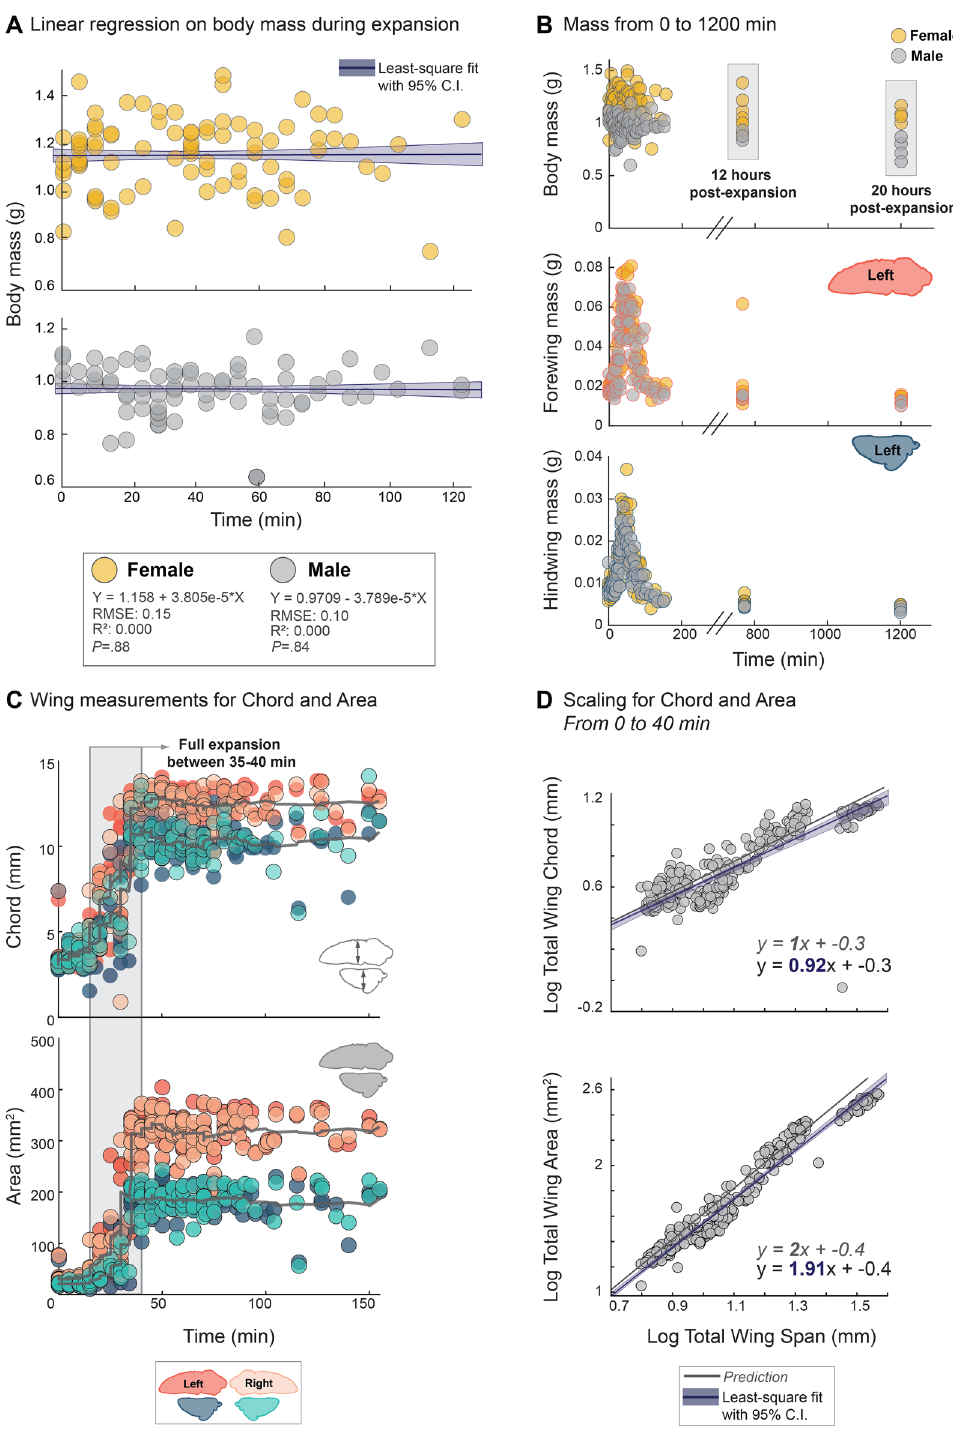
Figure 3. Body mass, area, and chord relationships. ( A ) Body mass trends for female (yellow) and male (gray) cicadas from t = 0 to 120 min. Data were pooled in the main study as there were no effects of sex on the statistical models. ( B ) Masses for body, left forewings, and left hindwings, for female (yellow) and male (gray) cicadas. Only the left side is represented, as there were no significant differences between the left and right wing mass trends. ( C ) Area and chord represented for all wings, both left and right; however, there were no significant differences between left and right measurements. ( D ) Scaling patterns of log total wing chord and area relative to log of wing span. These relationships followed predictions of geometric